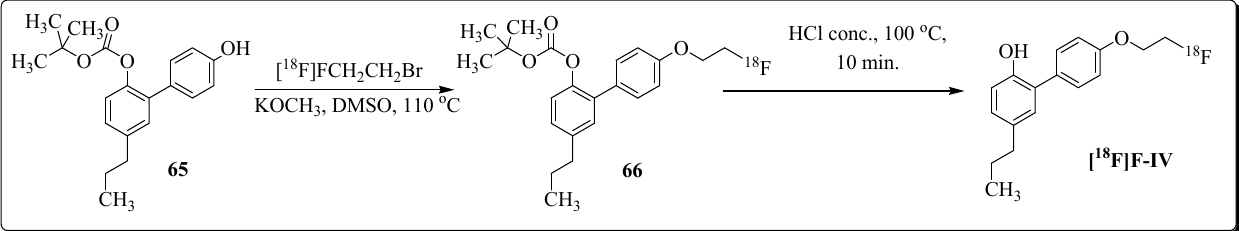
Figure 23. Radiosynthesis of [ 18 F]F-IV .